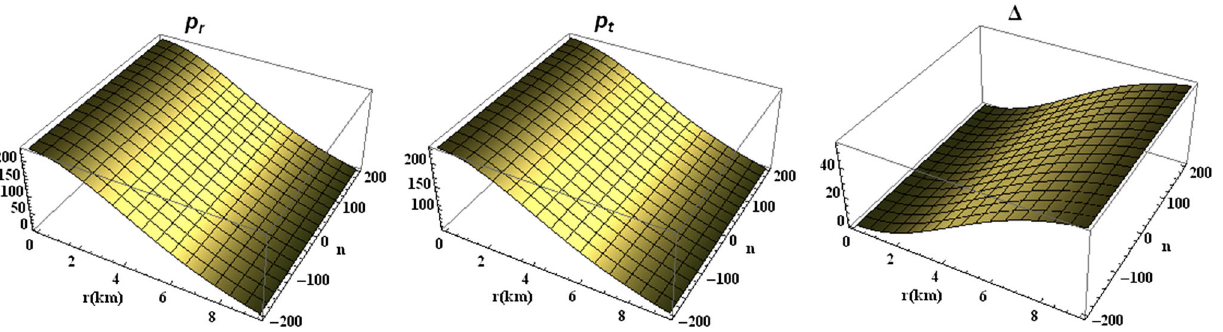
transverse pressure p t in MeVfm − 3 unit. (Right) along x -axis, y -axis and z -axis we have respectively plotted the radius of the star in km unit, the dimensionless quantity n which lies in the range − 200 ≤ n ≤ 200 and the anisotropic factor (cid:3) in MeVfm − 3 unit. All the profiles are drawn for a compact star of mass M = 1 . 85 M (cid:3) and radius of the star = 9 . 5 km. by fixing b = 0 . 0095 km −